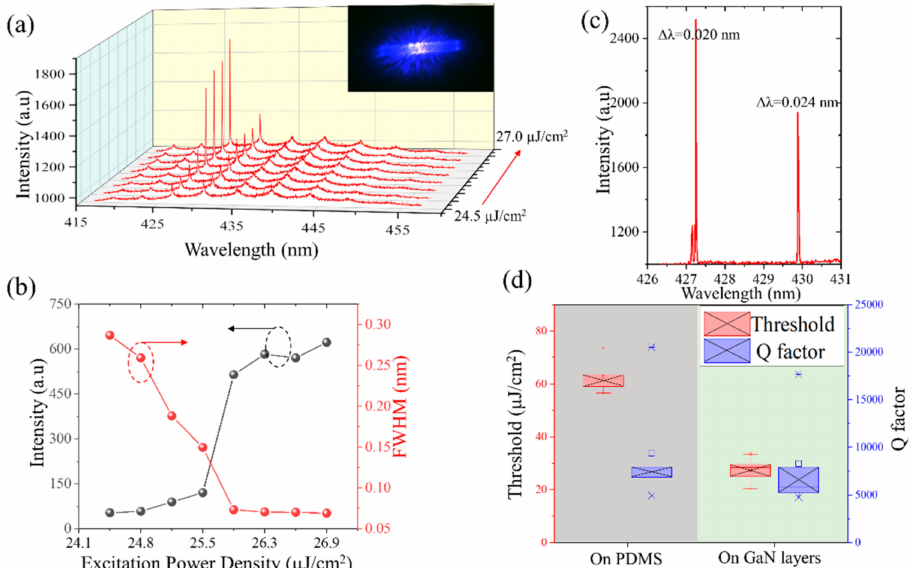
Figure 3. ( a ) PL emission spectra of microtube in PDMS under an energy density from 24.5 µ J/cm 2 to 27.0 µ J/cm 2 , the inset is an optical image, captured by the CCD, of a microtube pumped above the laser threshold. ( b ) The intensity of PL (black) and FWHM (red) as a function of the excitation energy density for the microtubes embedded in a PDMS film. ( c ) The PL spectrum of microtube with a narrow linewidth. ( d ) The box-plot is the threshold and Q factor of microtubes in PDMS or on the GaN